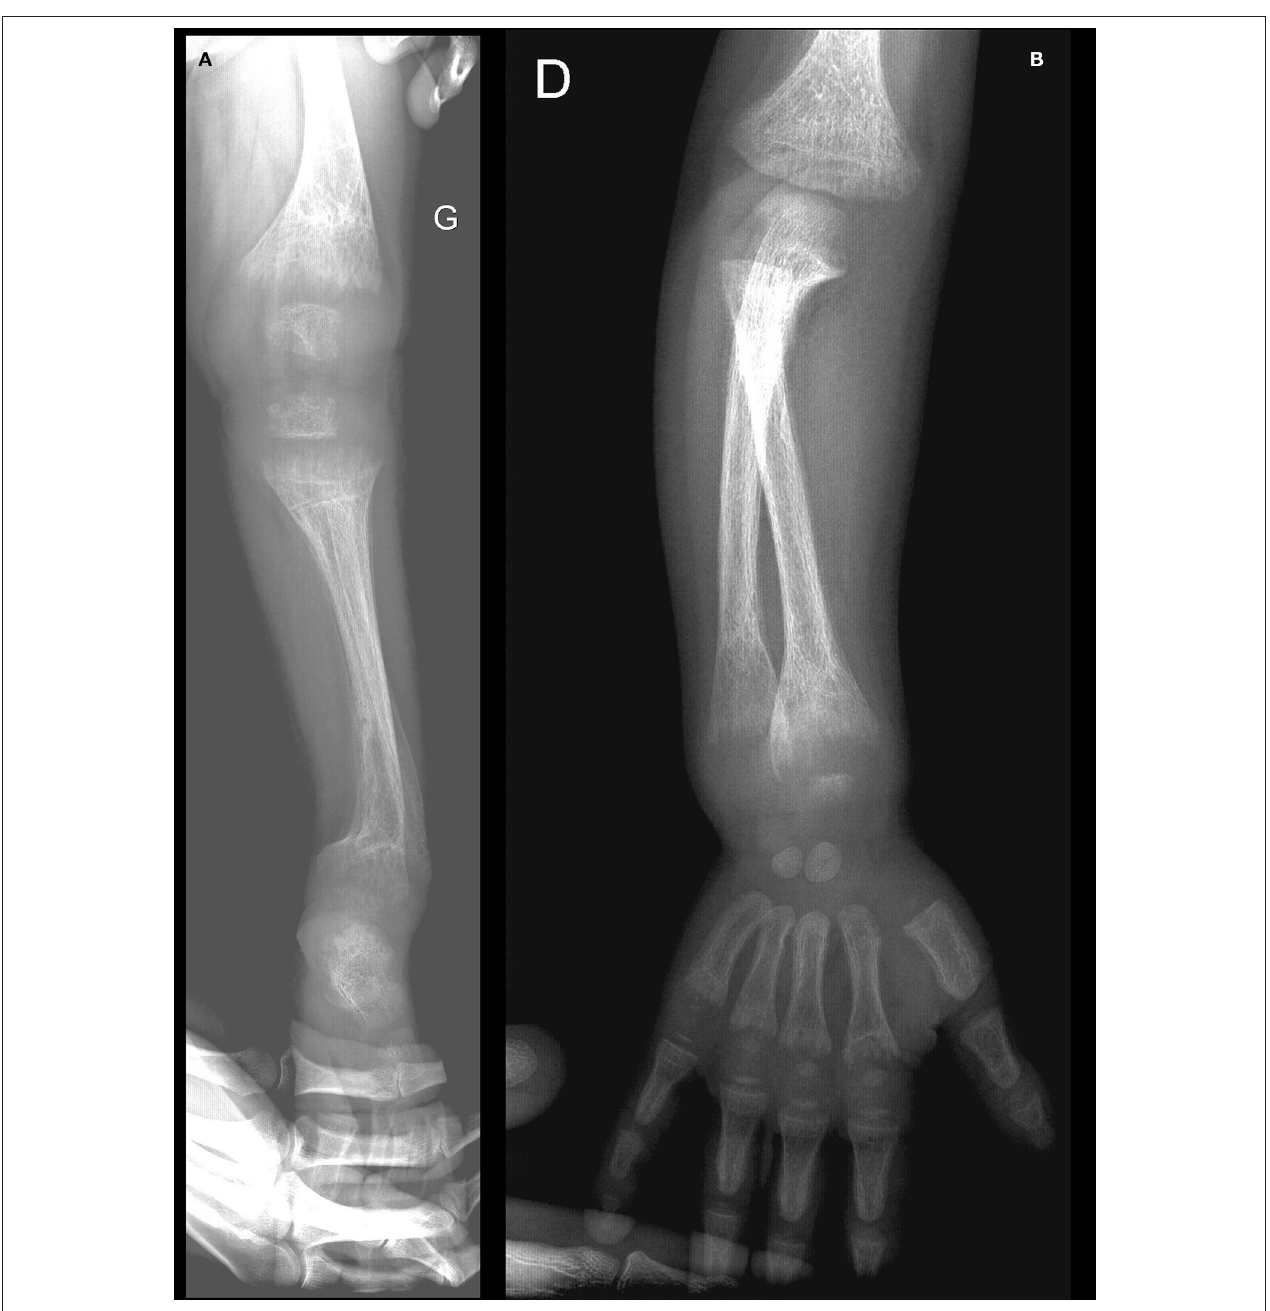
FIGURE 1 | (A,B) Rachitic changes of the lower (A) and upper (B) extremity bones (at